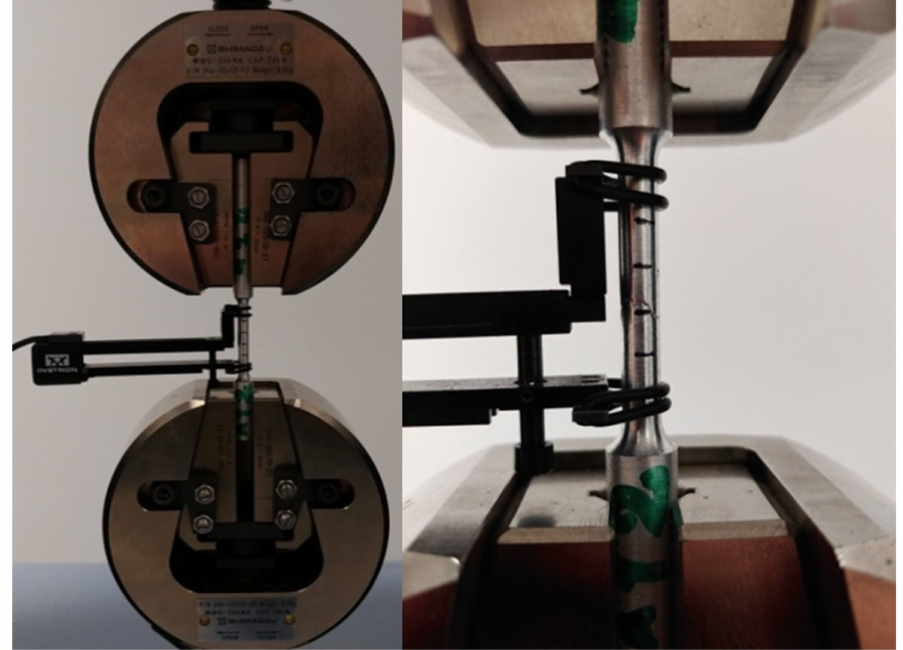
Figure 16. A sample made of connecting rod forgings placed in a testing